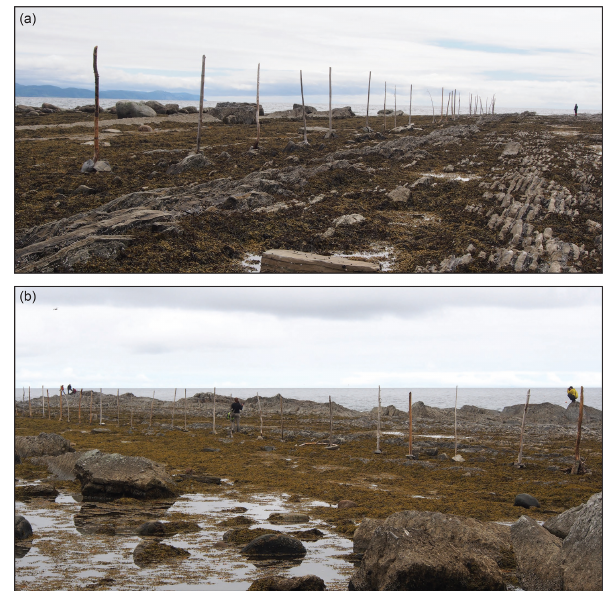
Figure 3. Completed installation viewed at low tide. (a) Completed Boundary | Time | Surface installation; artist for scale. (b) View of completed Boundary | Time | Surface installation with viewers engag- ing with the